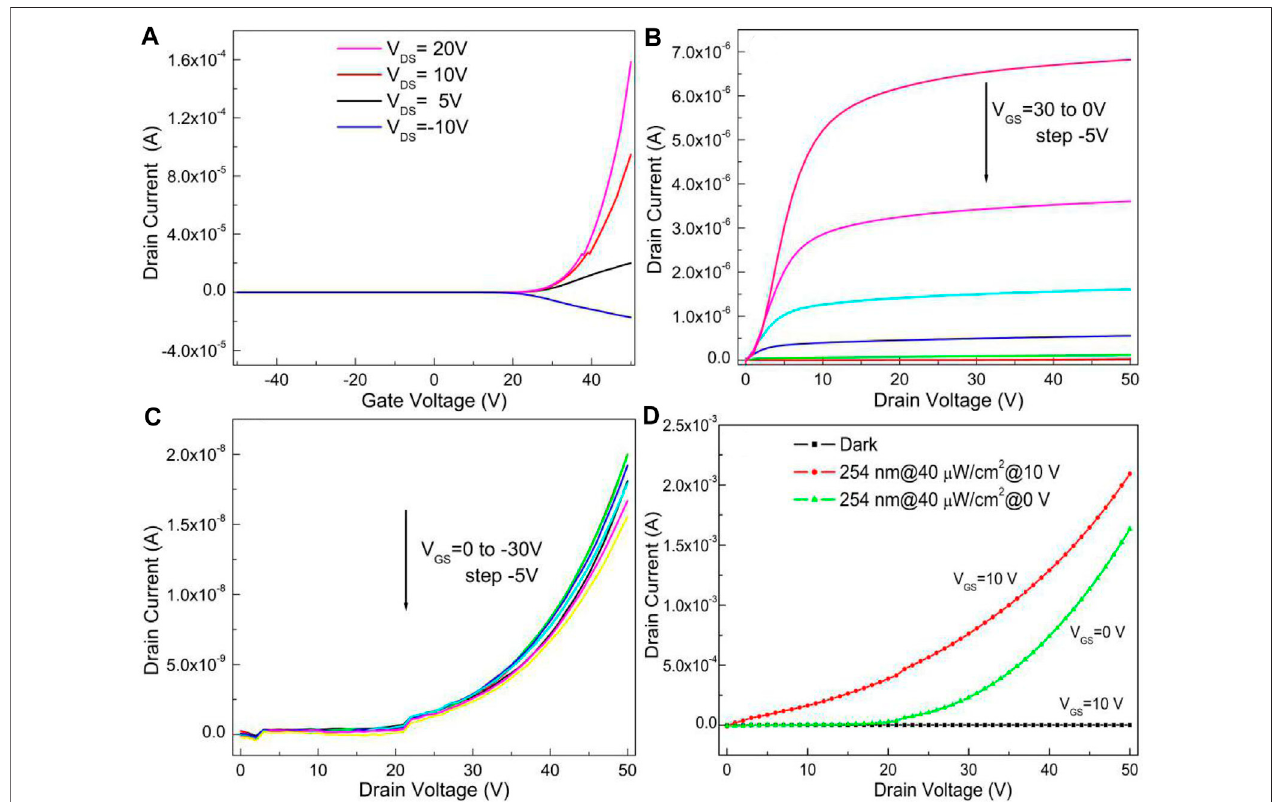
FIGURE 4 | (Color online) (A) Transfer characteristics I DS -V GS of the back-gate structure based on the β -Ga 2 O 3 fi lm for various drain voltages. Output characteristics under dark conditions for gate voltages (B) from 30 to 0 V and (C) from 0 to − 30 V, respectively. (D) Output characteristics for V GS (cid:2) 10 V under dark conditions and V GS (cid:2) 0 V and 10 V under 254-nm light illumination with a light intensity of 40 μ W/cm 2 .